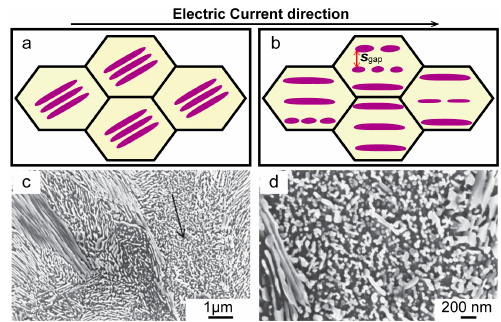
Figure 4. The formation of orientation microstructures in pearlite: ( a , b ) various configurations of pearlite microstructure [91]; ( c , d ) SEM images of samples after EPT [93].